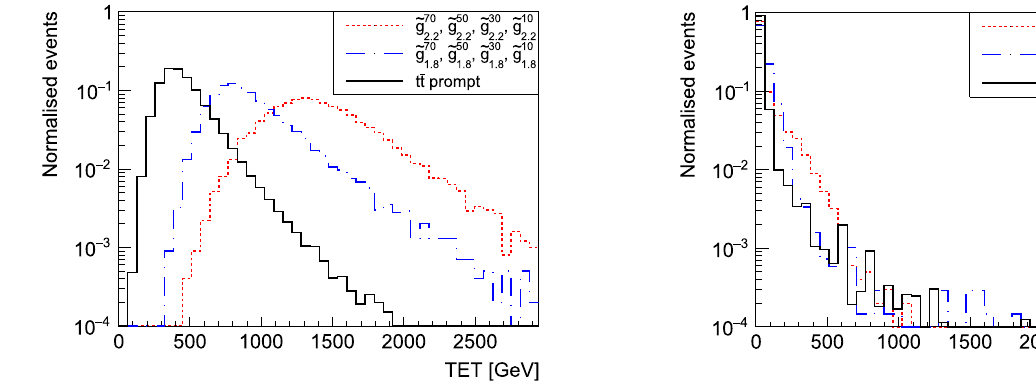
Fig. 73 Total transverse energy TET in the gluino ˜ g case